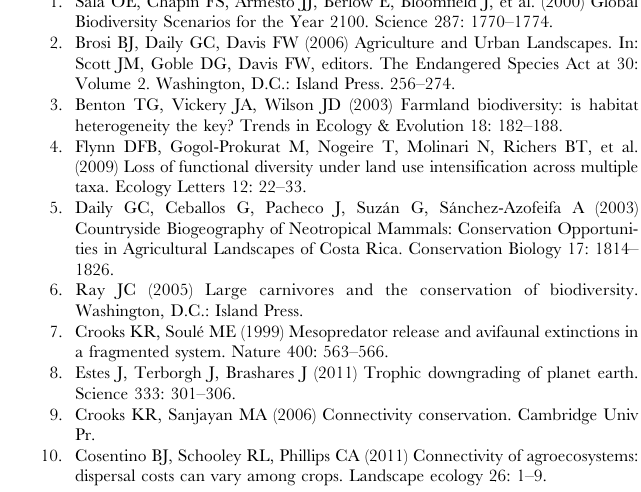
-2*log- likelihood